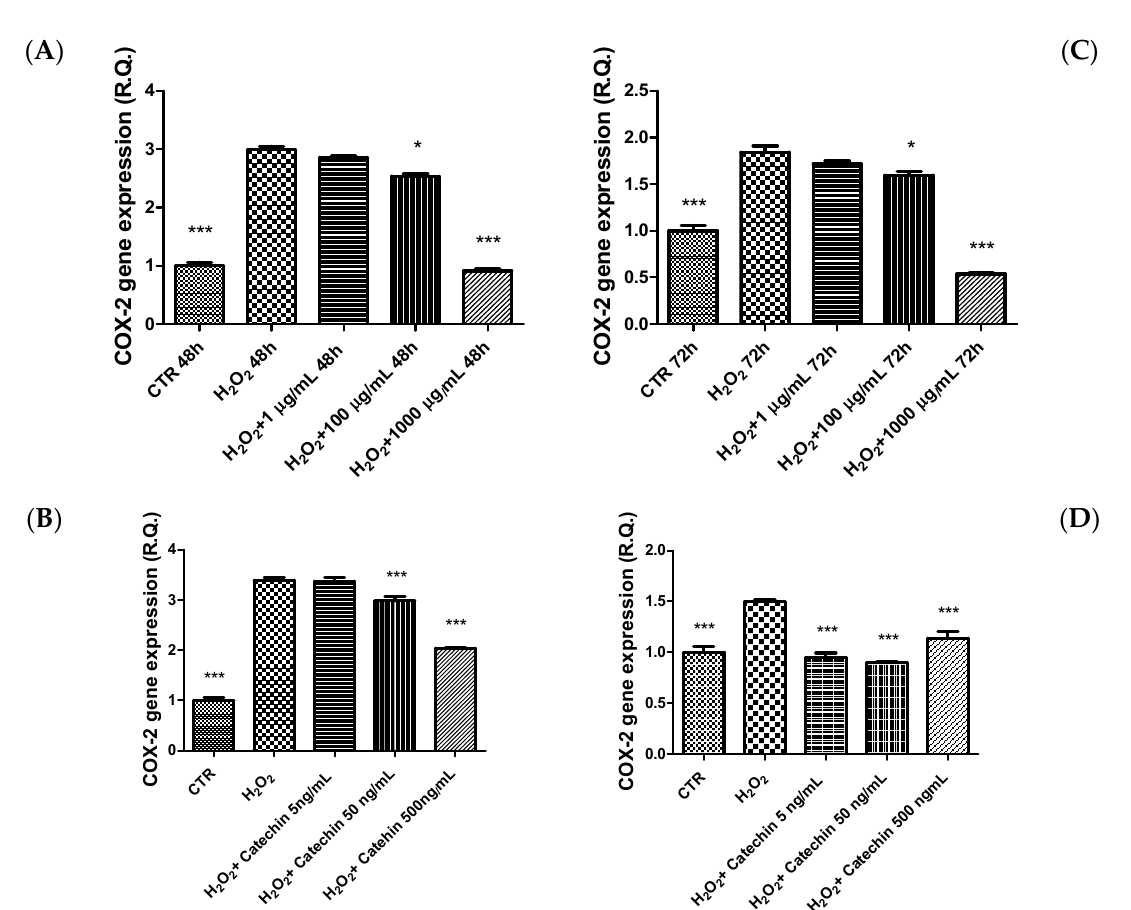
Figure 5. Inhibitory effects exerted by grape pomace water extract (1–1000 µg/mL) and catechin (5–500 ng/mL) on hydrogen peroxide (H 2 O 2 )-induced increase in cyclooxygenase-2 (COX-2) gene expression in HypoE22 cells. The efficacy of the extract was evaluated at different time points: 48 h ( A , B ); 72 h ( C , D ). ANOVA, p < 0.0001; * p < 0.05, *** p < 0.001 vs. respective hydrogen peroxide group (H 2 O 2 ).